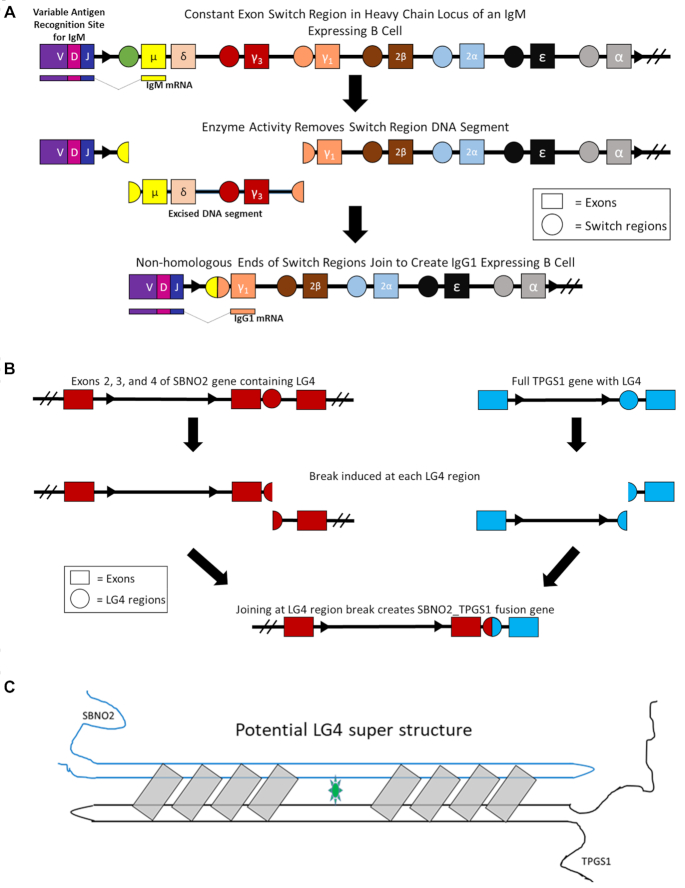
Recurrent translocations between LG4s. (A) Mechanism of isotype switching in activated B cells. Resulting mRNA indicated below genomic sequences. V; variable exon. D; diversity exon. J; joining exon. IgM; immunoglobulin M. IgG1; immunoglobulin G subclass 1. μ; immunoglobulin M heavy chain exon. δ; immunoglobulin D heavy chain exon. γ3; immunoglobulin G subclass 3 heavy chain exon. γ1;immunoglobulin G subclass 3 heavy chain exon. ϵ; immunoglobulin E heavy chain exon. α; immunoglobulin A heavy chain exon. 2β; immunoglobulin G subclass 2 beta heavy chain. 2α; immunoglobulin G subclass 2 alpha heavy chain (32,52,127–130). (B) Gene fusion (40,41) resulting from distinct LG4 breaks independently reported in breast (TCGA-BRCA) and cervical (TCGA-CESC) malignancies. SBNO2; Strawberry notch homolog 2. TPGS1; Tubulin Polyglutamylase Complex Subunit 1. (C) Model of potential LG4 super structure.